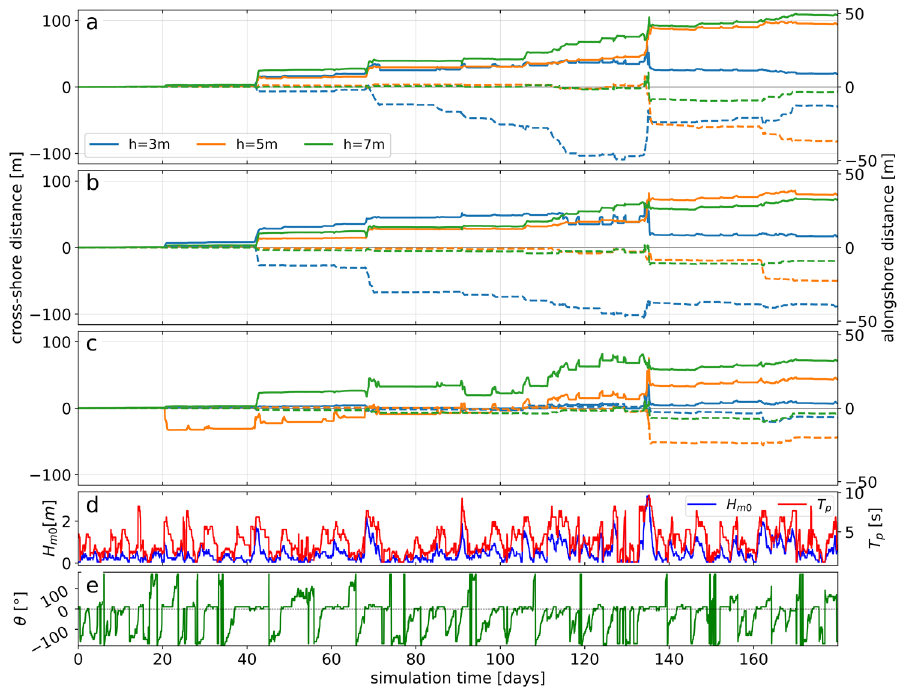
Figure 19. Time series of cross-shore (solid line) and alongshore (dashed lines) displacements of nearshore nourishment sediment for the Ogden Dunes scenario for 3 m (blue lines), 5 m (orange lines), and 7 m (green) placement depths, respectively. ( a ) Linear berm; ( b ) undulated berm; ( c ) discrete mounds; ( d ) offshore wave height and peak period; ( e ) wave direction relative to shore-normal.